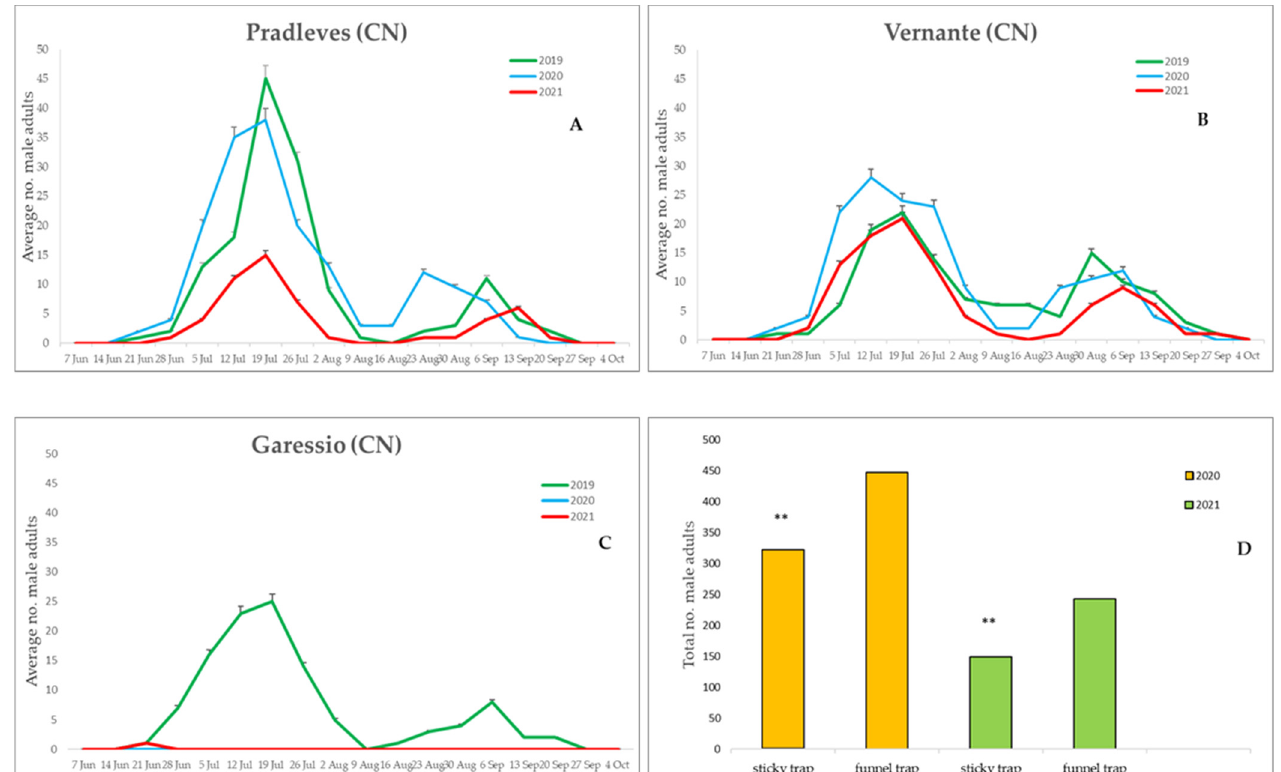
Figure 1. Seasonal flight activity of Cydalima perspectalis Walker recorded in Pradleves ( A ), Vernante ( B ), and Garessio ( C ) collected with pheromone-baited sticky traps in comparison with pheromone- baited funnel traps ( D ). Green line refers to 2019, blue line to 2020, and red line to 2021. Histograms refer to the comparison between sticky and funnel traps (yellow: 2020; green: 2021). The asterisks indicate significant difference (**, p < 0.01) between bars, according to the paired t -test.